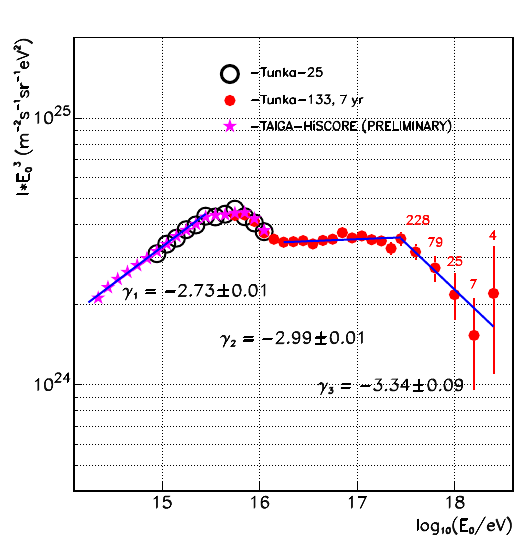
Figure 10. Comparison of energy spectra of di ff erent experi- ments in the wide energy range 10 14 - 10 20